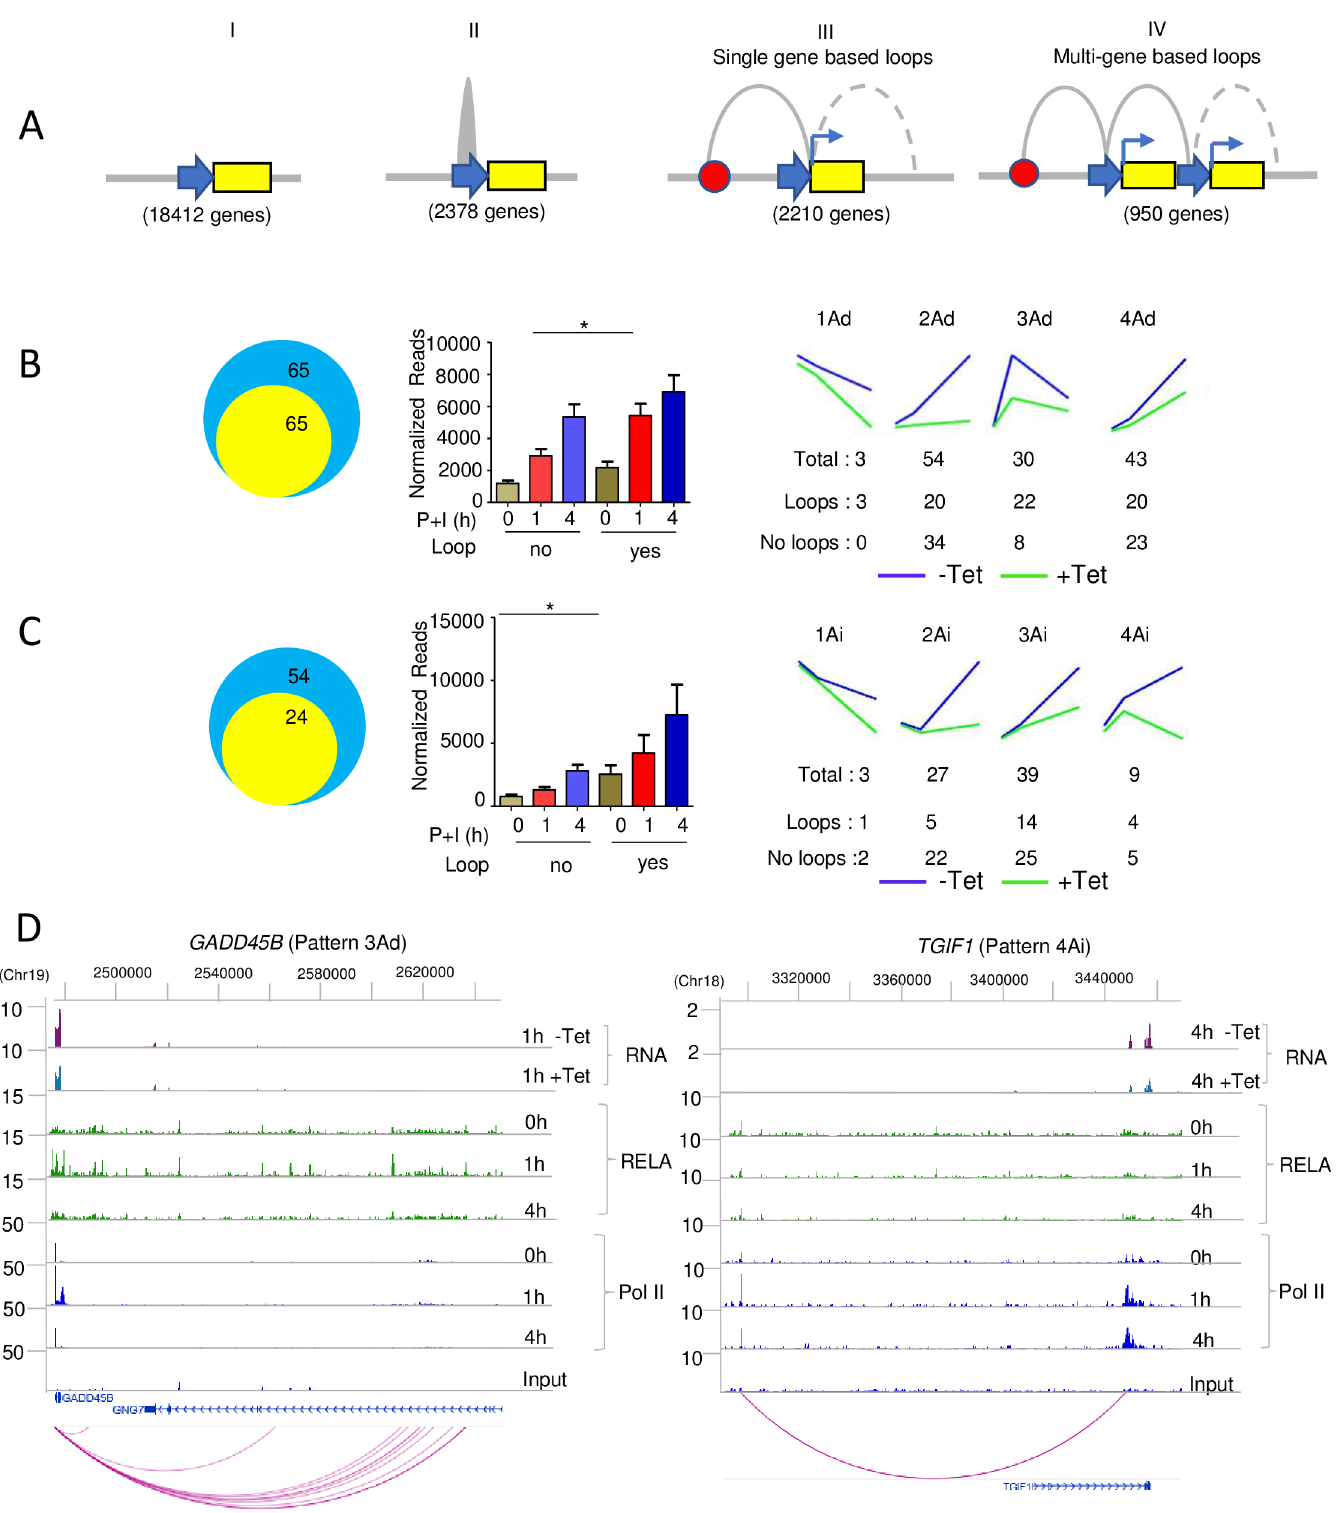
Fig 5. Kinetic patterning of NF- κ B-dependent gene expression. (A) Relationship of Pol II–associated chromatin looping to NF- κ B-dependent gene expression. Unactivated BJAB cells were used to carry out ChIA-PET after immunoprecipitation of cross-linked chromatin with anti-Pol II antibodies. Resulting sequence data were analyzed and categorized according to the type of promoter status. Category I = genes with no Pol II (no loops); II = genes with Pol II at promoter (no loops); III = genes